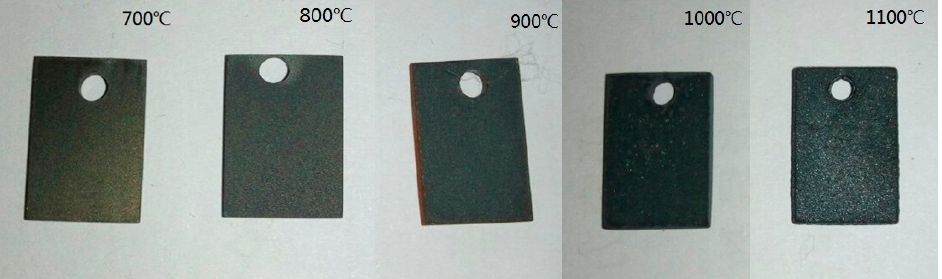
Figure 2. Macroscopic morphology of the Fe–1Cr–0.2Si steel specimens observed by the naked eye after 120 min of oxidation.